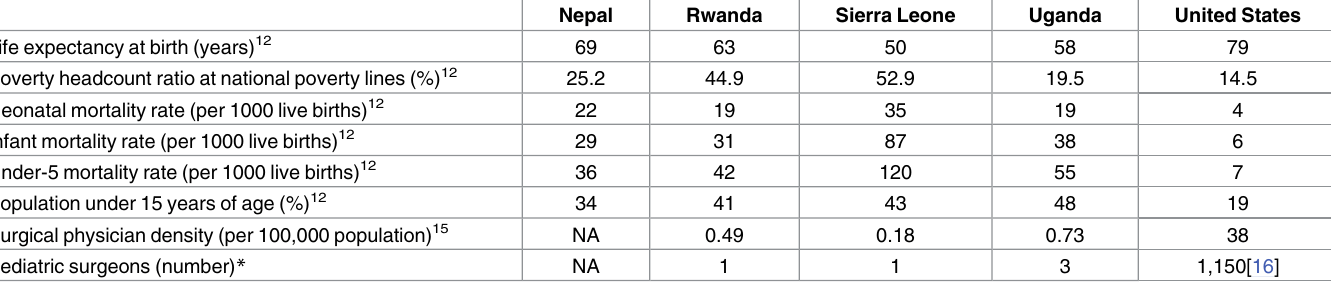
Table 1. Child health indicators and surgery providers in 4 low- and middle-income countries compared to